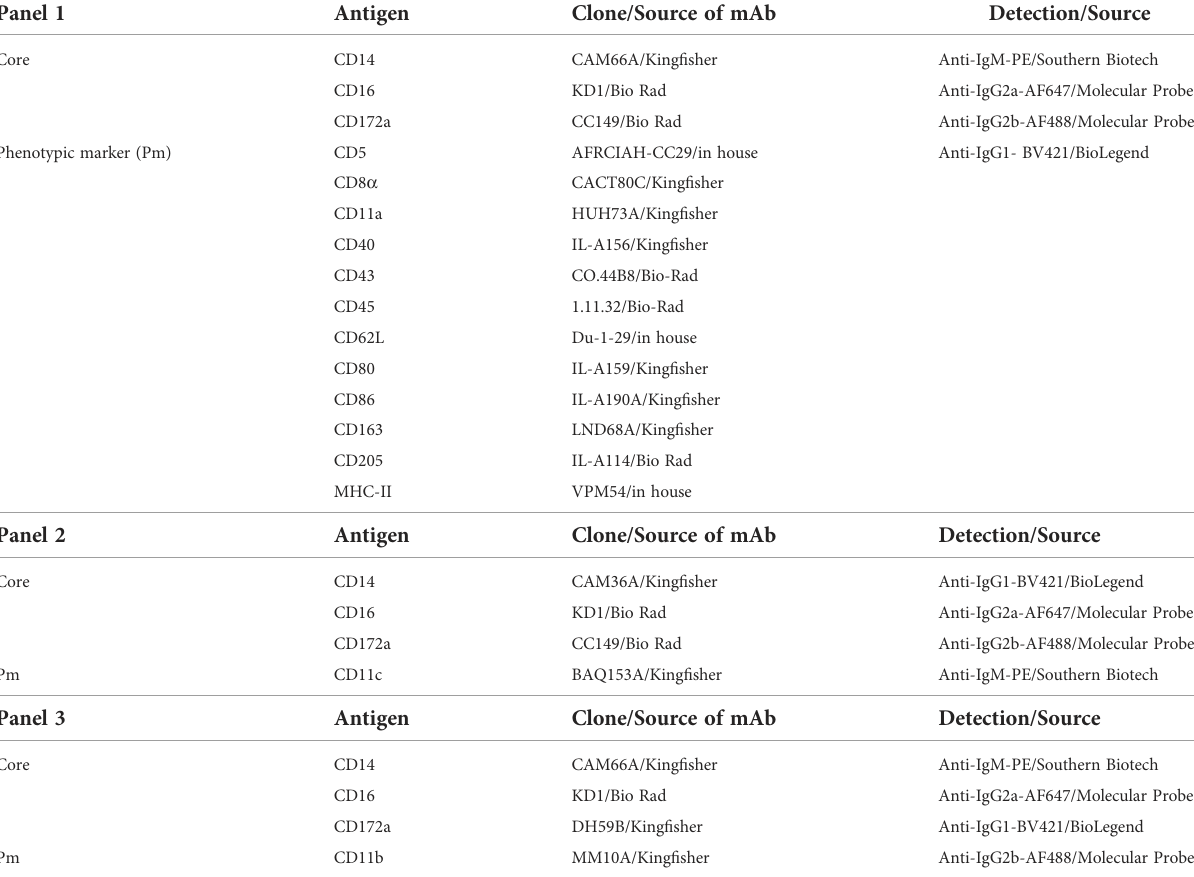
TABLE 1 Antibodies used for fl ow-cytometric phenotyping of bovine monocyte subsets. Panel